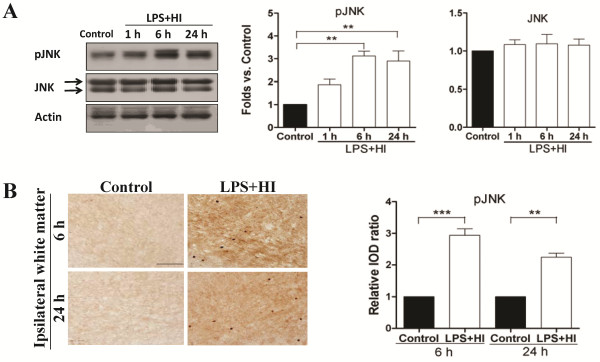
Upregulation of JNK activation in lipopolysaccharide-sensitized hypoxic-ischemic white matter injury. (A) Immunoblotting of white matter in the lipopolysaccharide (LPS) + hypoxic-ischemic (HI) group showed there was an early rise of phospho-c-Jun N-terminal kinase (p-JNK) expression at 1 h, which peaked at 6 h and persisted at 24 h post-insult. The JNK expression did not differ between the control and LPS + HI groups at various time points post-insult. (B) p-JNK immunohistochemistry at 6 and 24 h post-insult showed the LPS + HI group (n = 10) had significantly higher p-JNK immunoreactivities in the white matter of the ipsilateral hemisphere than the control (n = 7) groups. Scale bar =100 μm in (B). Values are means ± SEM. ***P < 0.001, **P < 0.01.